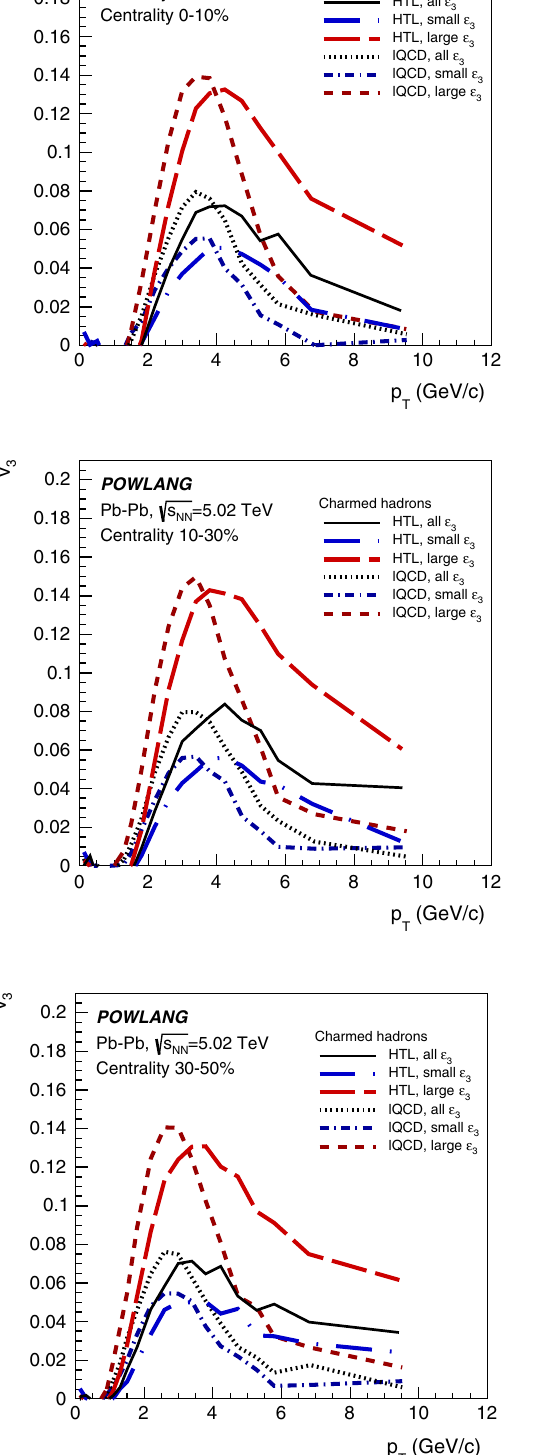
to the 60% lowest- (cid:7) 3 selection of events are compared to the unbiased case. For both choices of transport coefficients the results display a strong and similar sensitivity to the initial